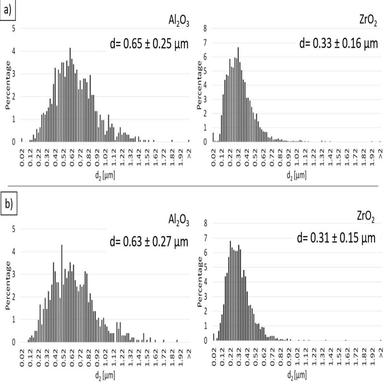
Histograms of Al2O3 and ZrO2 grain size distribution depending on the solid phase content in the composites: a) Series I - 40 vol.%of solid phase with 10% vol. of ZrO2, b) Series II - 45 vol.%of solid phase with 10% vol. of ZrO2.